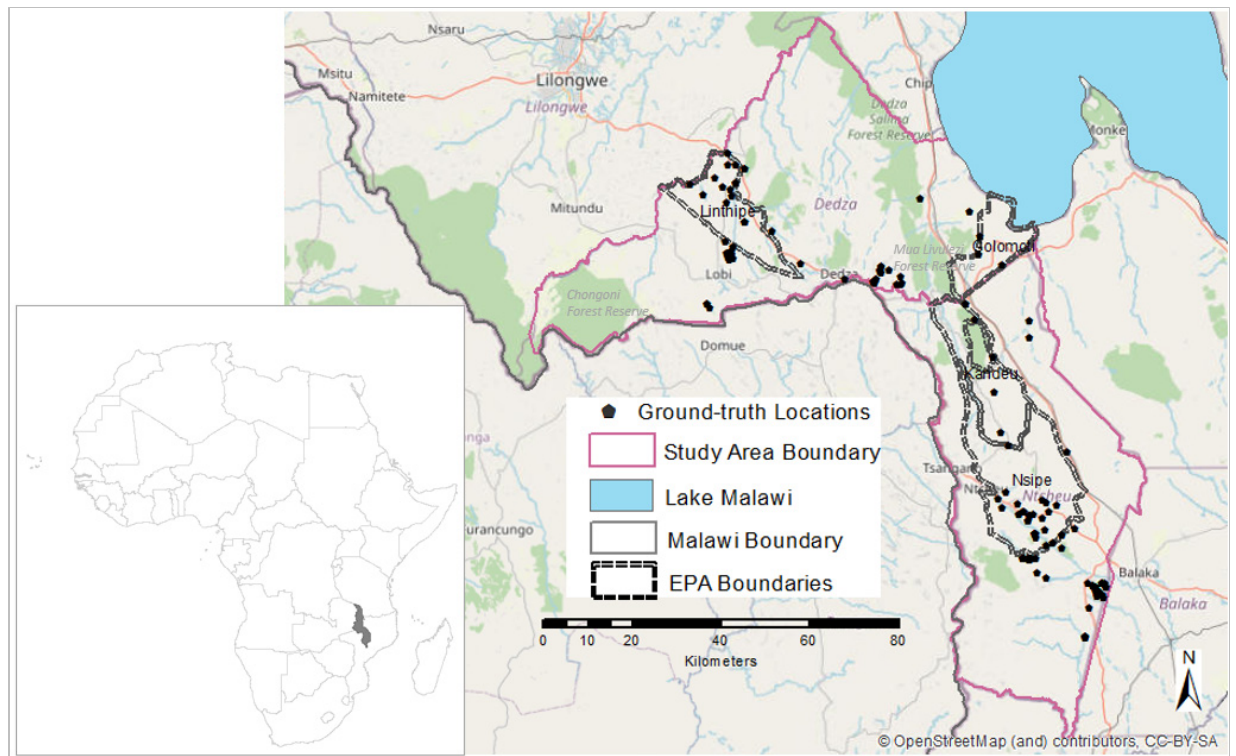
Figure 1. Study Area of two districts located in Central Malawi. The Dedza district is the upper study area while The Ntcheu district is the lower area. The figure also shows the boundaries of four agriculture extension administrative areas called Extension Planning Areas (EPA) and ground-truth field observations locations.